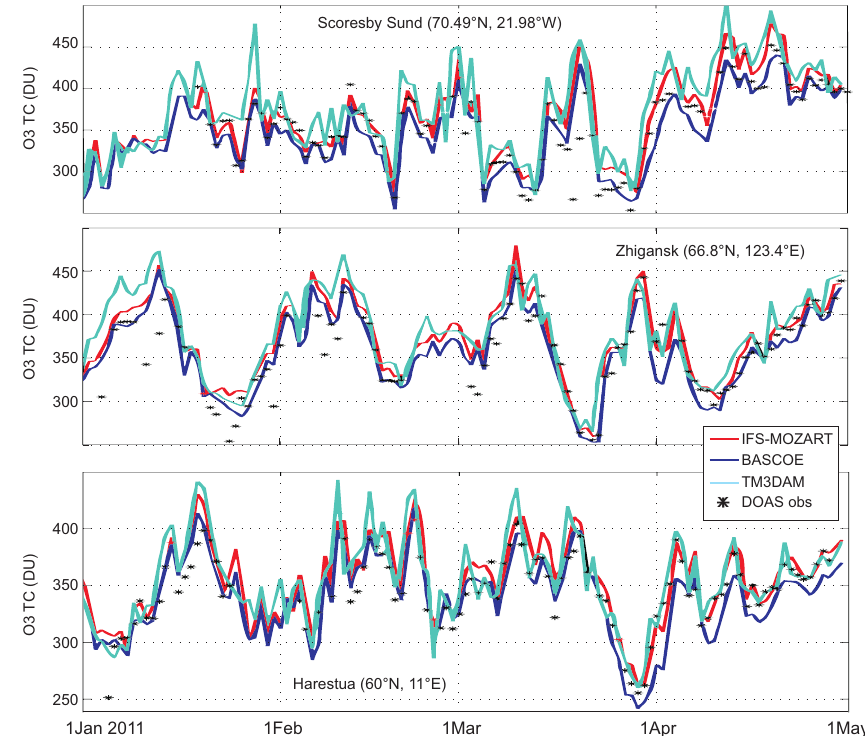
Figure 9. Comparison of daily averaged total ozone columns (expressed in Dobson Units) for IFS-MOZART (red), BASCOE (blue), and TM3DAM (cyan) vs. ozone measurements from three DOAS stations in the Arctic: Scoresby Sund (70.49 ◦ N, 21.98 ◦ W); Zhigansk (66.8 ◦ N, 123.4 ◦ E); and Harestua (60 ◦ N, 11 ◦ E).